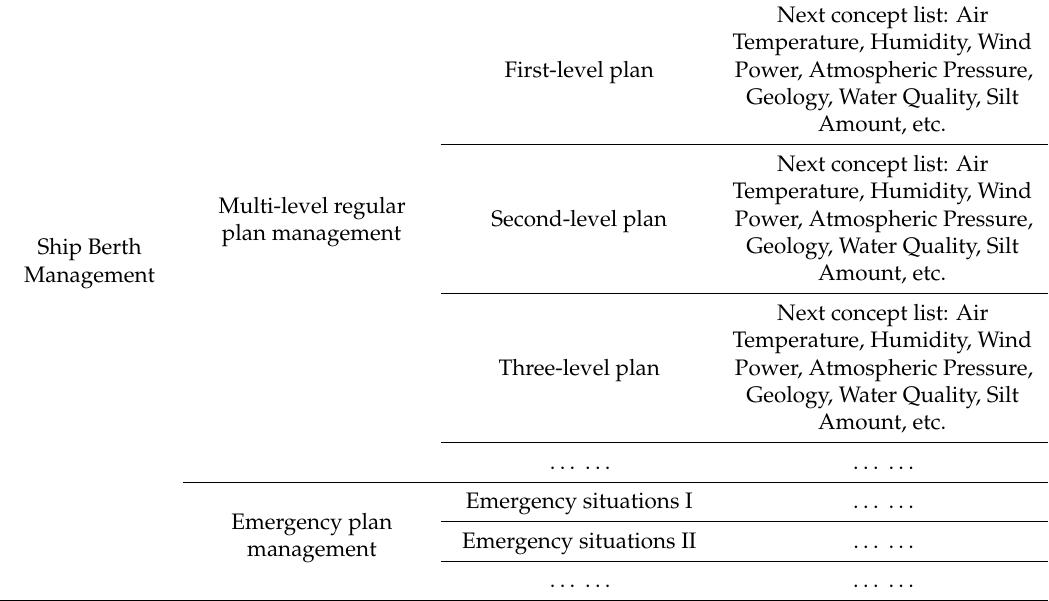
Table 2. The Ship Berth Management